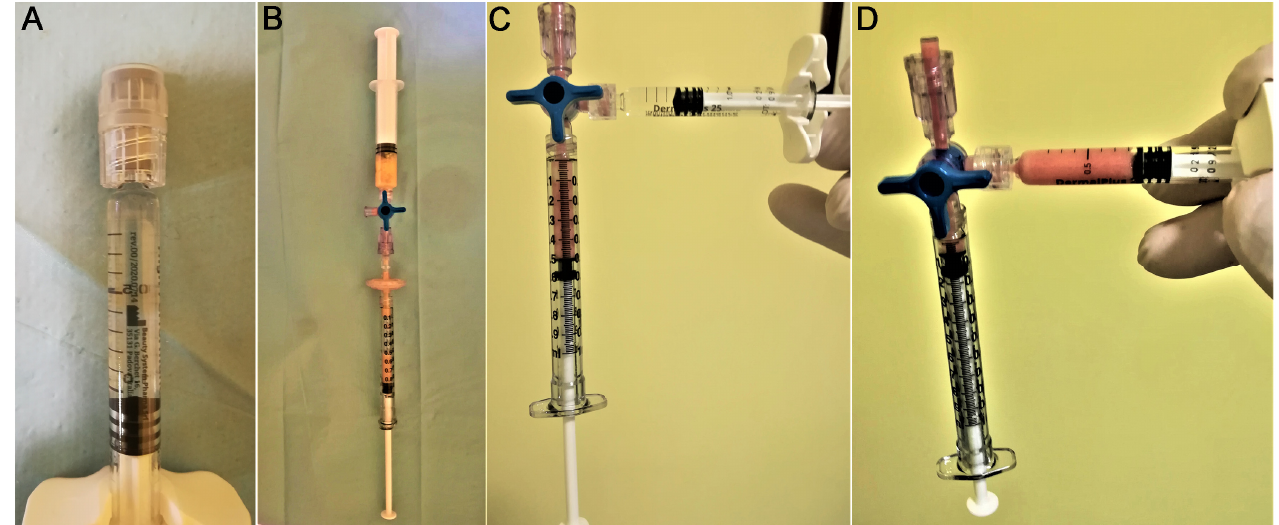
Figure 1. Procedure to mix microfragmented fat with hyaluronic acid. ( A ) Hyaluronic acid prefilled syringe; ( B ) Filtration of the collected and fragmented fat tissue; ( C , D ) mixing of the fragmented adipose tissue with hyaluronic acid in a closed system to guarantee sterility.